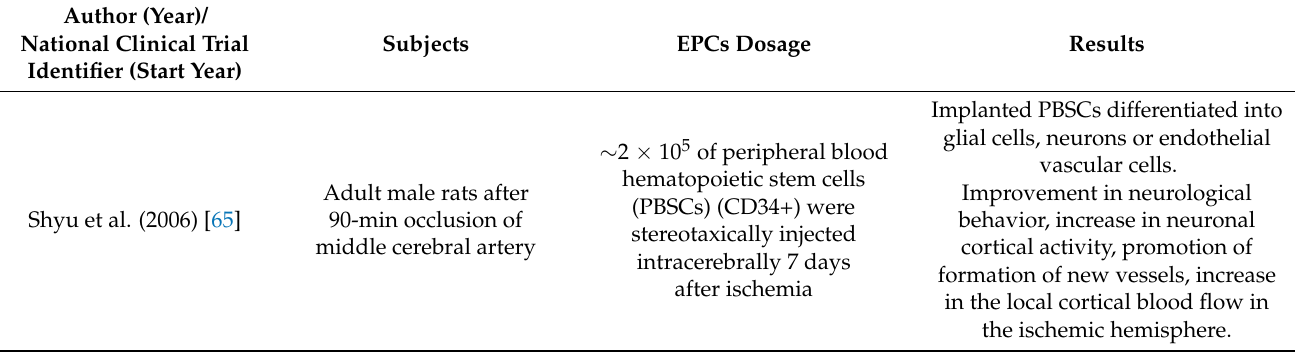
Table 4. A summary of finished and ongoing studies on the use of EPCs in ischemic